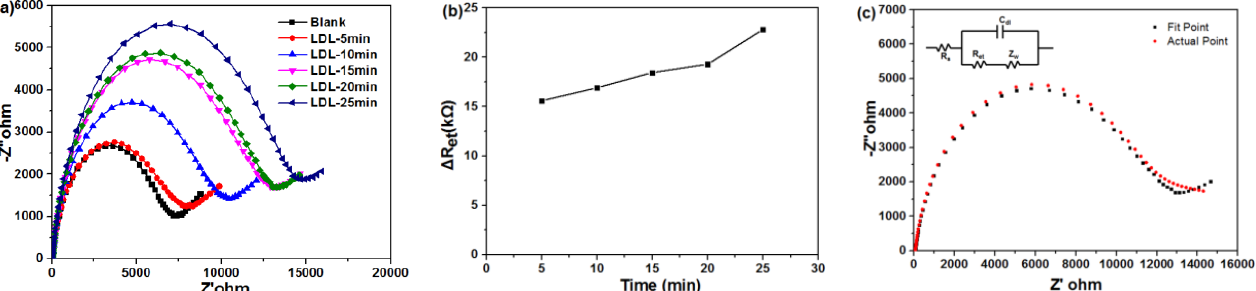
Figure 4. ( a ) Impedance responses with different time to the same concentration of LDL in PBS solution on the β -CD-Au modified electrodes. Faradaic impedance spectra were recorded in PBS (50 mM, pH 7.0) solution containing 0.1 M KCl and 5 mM K 3 [Fe(CN) 6 ]/K 4 [Fe(CN) 6 ]; ( b ) Relationship of ∆ Ret with the incubation time on the response of EIS; ( c ) Nyquist diagram for faradaic impedance spectra of LDL with 15 min in PBS (50 mM, pH 7.0) solution containing 0.1 M KCl and 5 mM K 3 [Fe(CN) 6 ]/K 4 [Fe(CN) 6 ]: actual (red cubic), fitting (green cubic), and the related Equivalent circuit for the impedance spectroscopy.